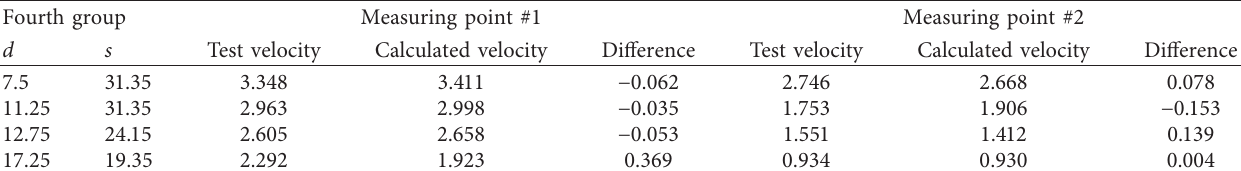
Table 8: Comparison of calculated values and measured values of the fourth set of measuring